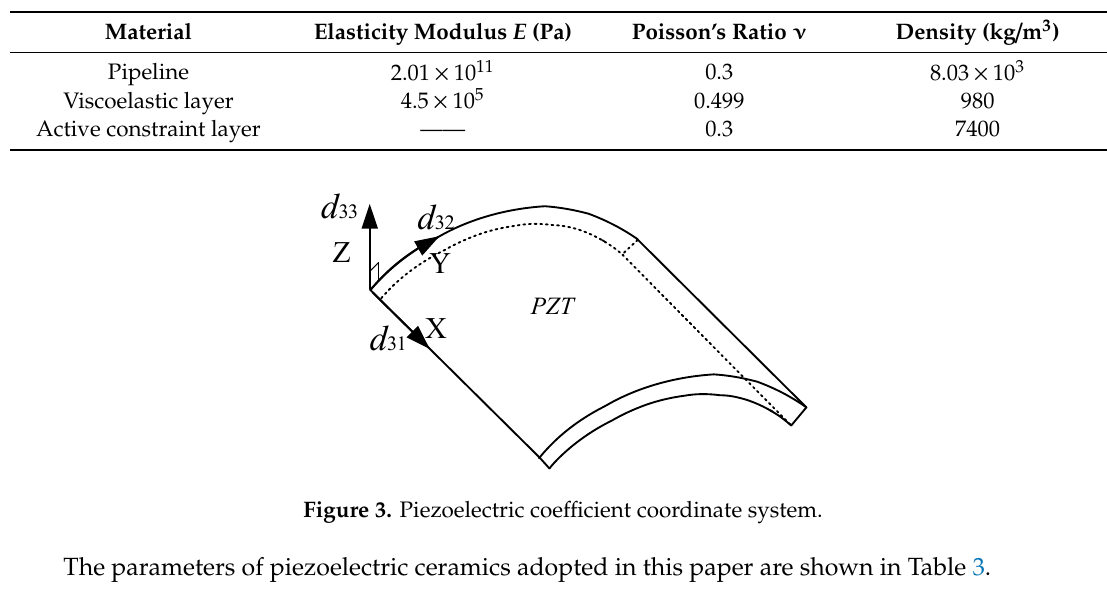
7400 Table 3. Performance parameter of the piezoelectric confinement layer.